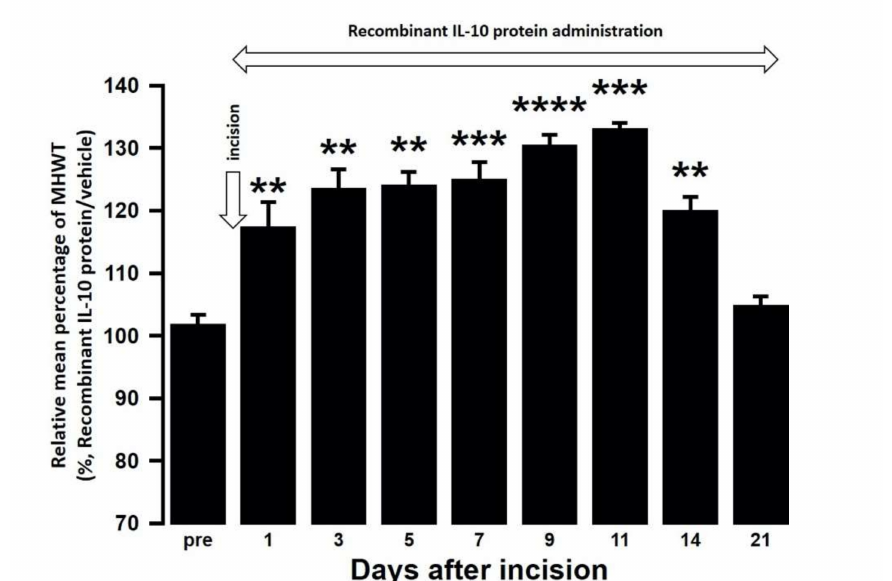
Figure 9. Changes in MHWT in SAMP8 mice treated with either a recombinant IL-10 protein or vehicle following palatal mucosal incision. The relative mean percentage MHWT was calculated over 21 days using the following formula (100 × MHWT in SAMP8 mice treated with recombinant IL-10 protein / MHWT in SAMP8 mice treated with vehicle). Data represent mean ± SD ( n = 5 for SAMP8 incision mice treated with a recombinant IL-10 protein, and SAMP8 incision mice treated with vehicle. ** p < 0.01, *** p < 0.001, **** p < 0.0001 compared to pre value; one-way repeated measures ANOVA followed by Tukey’s multiple comparison